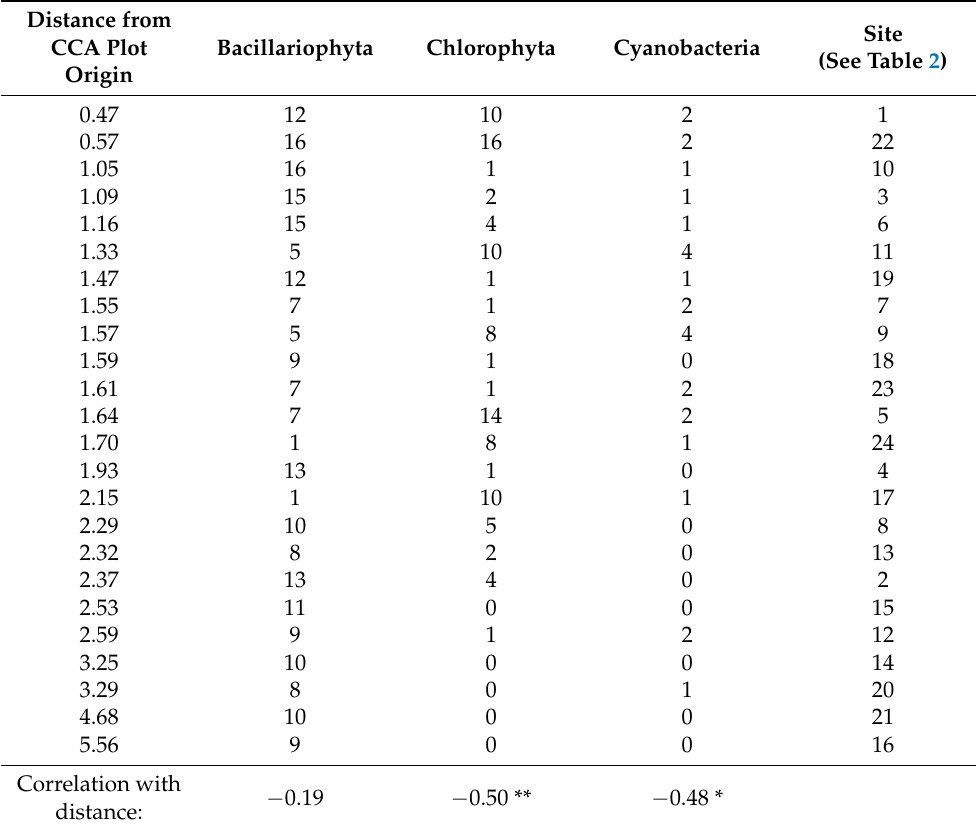
Table 8. Correlation of the major phytoplankton divisions diversity with distance from the CCA plot